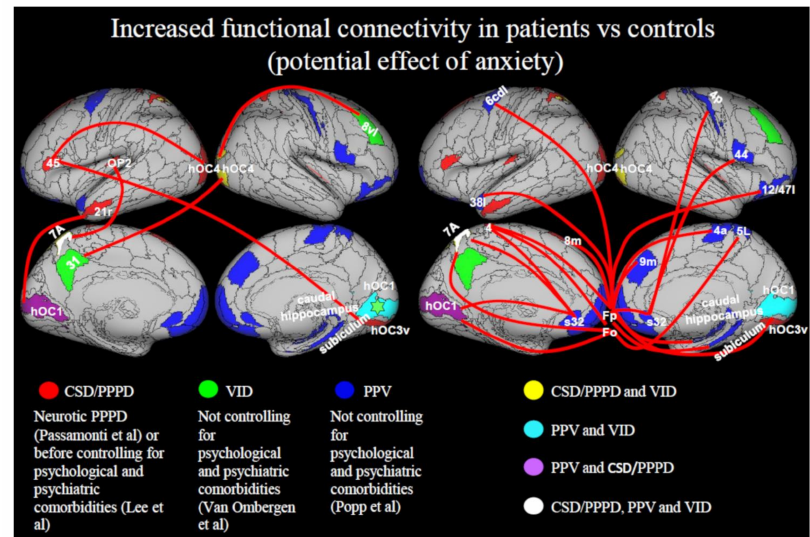
Figure 5. Increased functional connectivity in patients vs. controls (potential effect of anxiety). Significant results are an effect of neuroticism in patients with PPPD (Passamonti et al. [47]), or derive only from analyses in which psychiatric comorbidities were not controlled for. Left Panel: Passamonti et al. [47] considered the effect of neuroticism after matching the control group for neuroticism and found increased connectivity in neurotic patients in response to vertical vs. horizontal stimulation between left BA45 and: (1) right ventral hOC3 (hOC3v), (2) left hOC4. Before controlling for psychiatric comorbidities, Lee et al. [42] (in the seed-based analysis) found increased connectivity between left OP2 and left superior parietal lobe (SPL, 7A) and between left V1 (hOC1) and left temporal pole (rostral BA21 = 21r). Van Ombergen et al. [42] found increased connectivity of right primary visual cortex (hOC1) with the rest of the brain in patients with VID vs. controls. They also found increased functional connectivity between the right visual associative cortex (hOC4) and: (1) right middle frontal gyrus (8vl), (2) left precuneus (31). Right panel: Popp et al. [48] found increased connectivity in response to visual motion stimuli between Fronto-polar (Fp) cortex and: (1) right orbital gyrus (lateral BA 12/47 = 12/47l), (2) right subiculum, (3) bilateral primary motor area (BA4, 4a), (4) left medial temporal pole (lateral BA38 = 38l), (5) right s32, (6) right anterior cingulate cortex (9m), (7) left pre-SMA (BA 8 m), (8) right V1 (hOC1), (9) left premotor cortex (caudal dorso-lateral BA6 = 6cdl), (10) right hippocampus; between orbito-frontal cortex (Fo) and: (1) left V1 (hOC1), (2) bilateral SPL (5L, 7A), left primary motor area (BA4); between subgenual anterior cingulate cortex (s32) and: (1) right inferior frontal gyrus (BA44), (2) left V1 (hOC1), (3) bilateral primary motor area (4, 4p), (4) left 7 A. Connections between regions have been split into 2 panels to avoid overcrowding of the image. Regions from CSD/PPPD are in red, regions from PPV are in blue, regions from VID are in green. Regions in common between CSD/PPPD and VID are in yellow; regions in common between CSD/PPPD and PPV are in purple; regions in common between PPV and VID are in cyan; regions in common between CSD/PPPD, PPV and VID are in white. Regions from the Anatomy atlas [52] and Brainnetome atlas [53] are overlapped onto the Conte69 inflated brain in workbench viewer